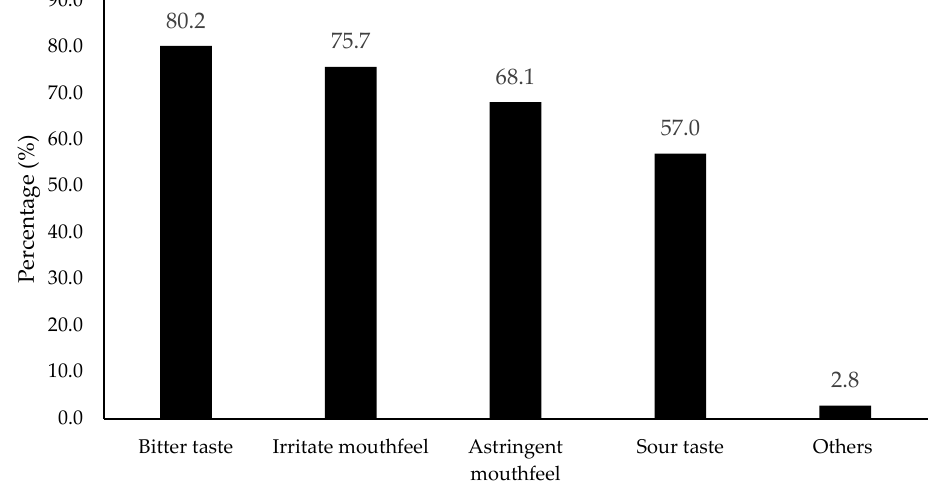
Figure 6. Percentage (%) for the attributes that were not expected from flavored water/beverage ( n = 901). Others included carbonation, sweet, artificial flavors, lingering taste, and chemical taste according to the collected data.